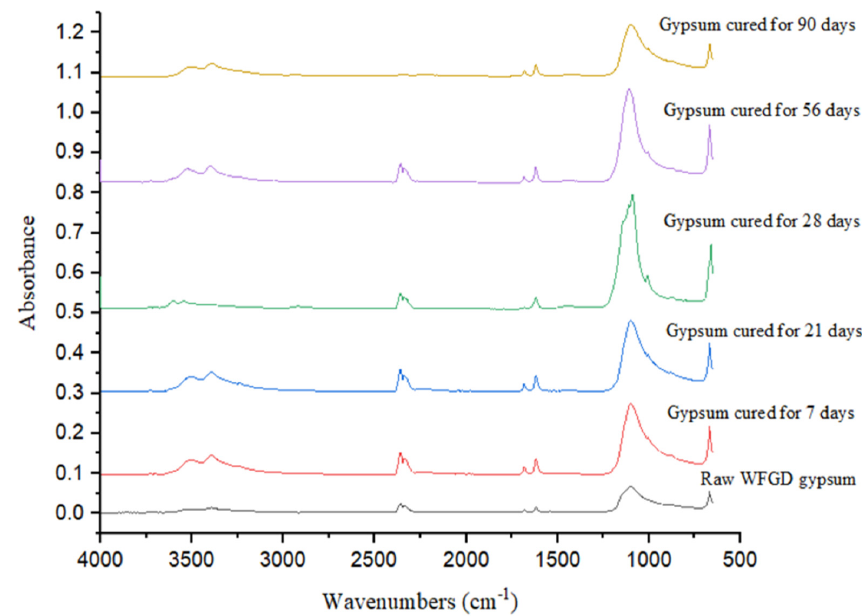
Figure 9. FTIR spectra of WFDS gypsum at ambient temperature from 7 to 90 days.